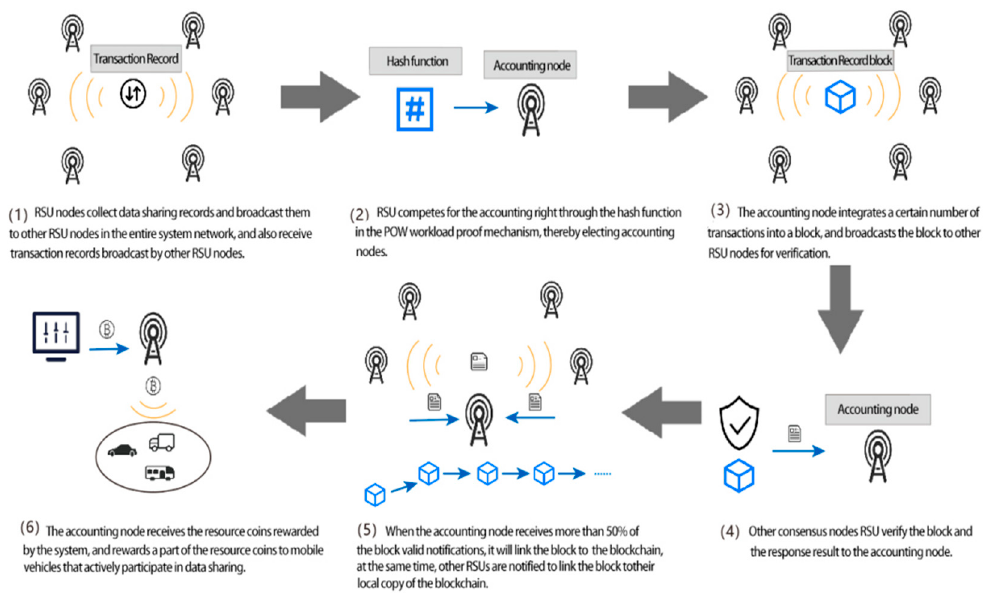
Figure 3. Block generation and link flow chart.